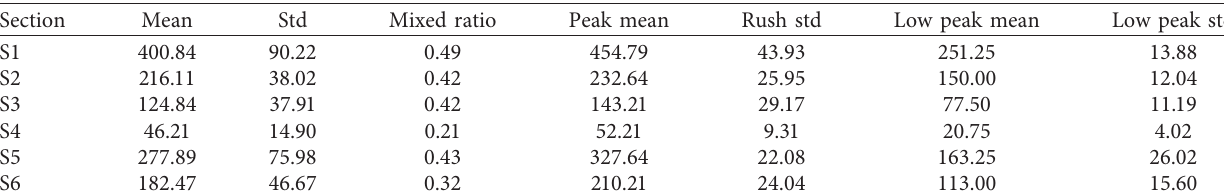
Table 3: The properties of the six selected sections.